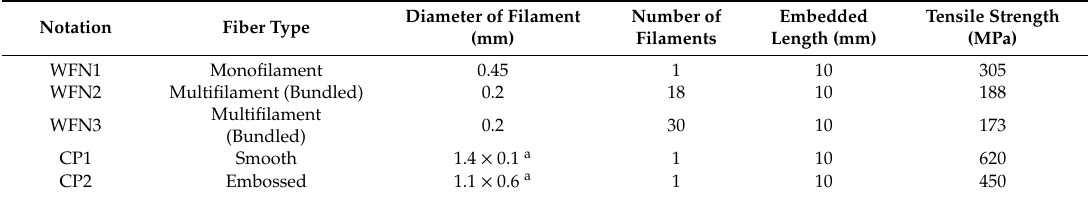
Table 2. Properties of the synthetic